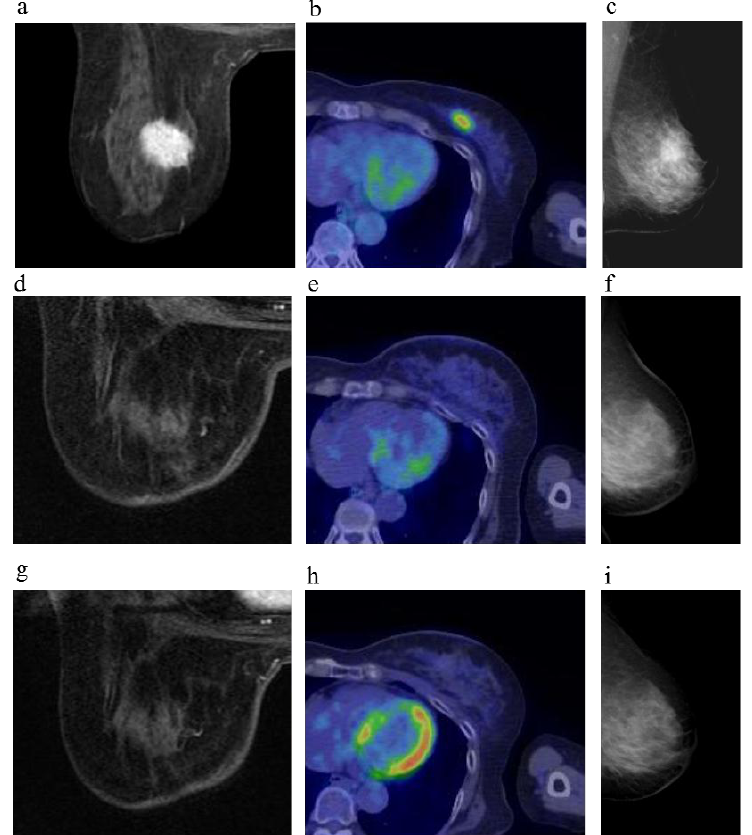
Figure 2. A 64-year-old female (case 3 in Tables 1–3) with left breast cancer (cT2N0M0). CE